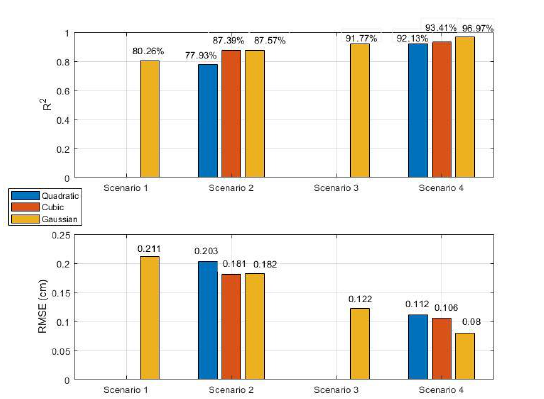
Figure 10. Comparison between results of four scenarios for training data